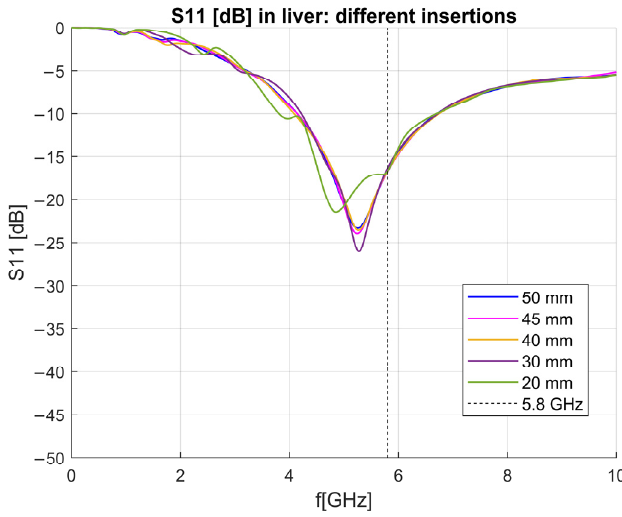
Figure 19. S 11 of the antenna immersed in the liver at different lengths.